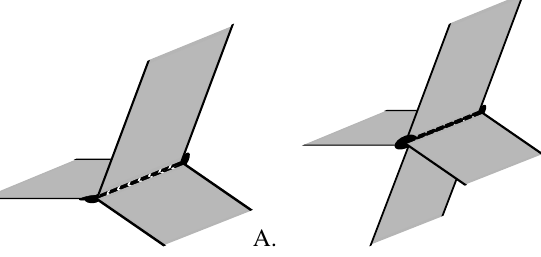
Figure 1: 3-point and 4-point contact